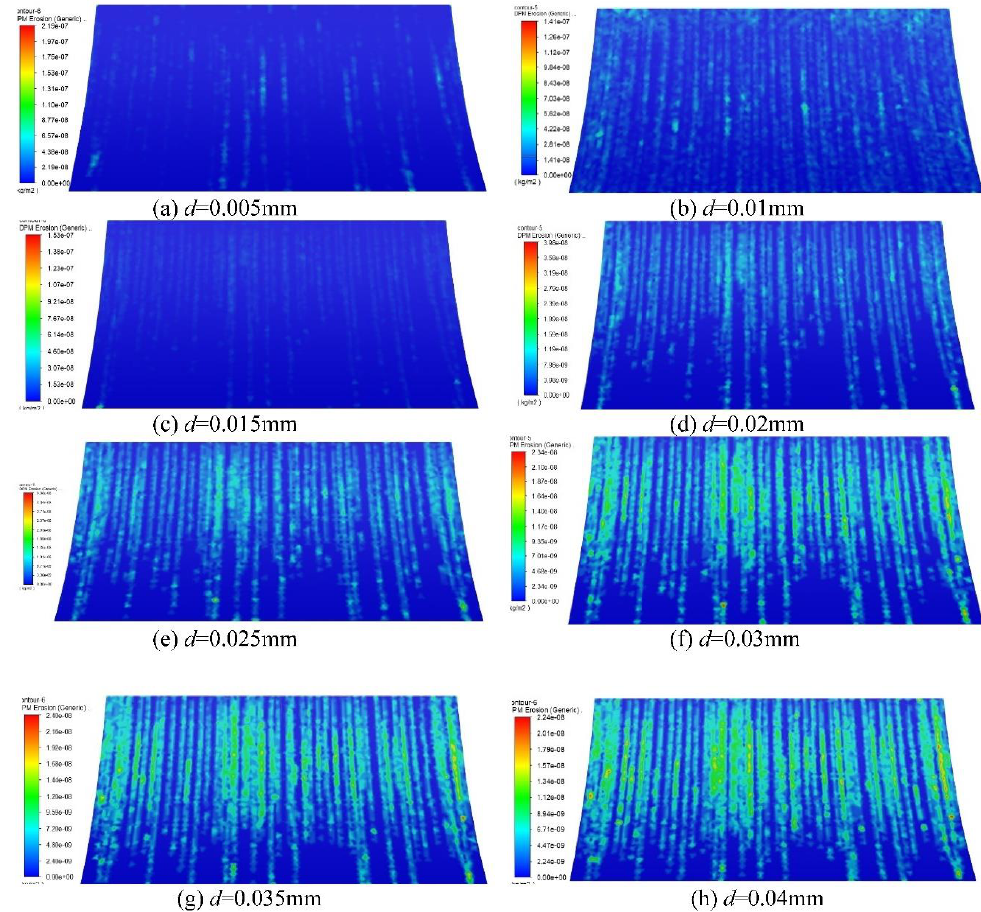
Figure 7. Erosion cloud diagram of gate leaf under sediment of different diameters. The relationship between the maximum erosion amount and sediment diameter is shown in Figure 8. When the particle diameter varies from 0.005 mm to 0.04 mm, the re- lationship between sand particle diameter and erosion amount is not monotonic: The ero- sion amount increases with the increase in particle size when the sediment diameter is 0.005 mm~0.015 mm, and decreases with the decrease in particle size when the sediment diameter is 0.015 mm~0.04 mm.